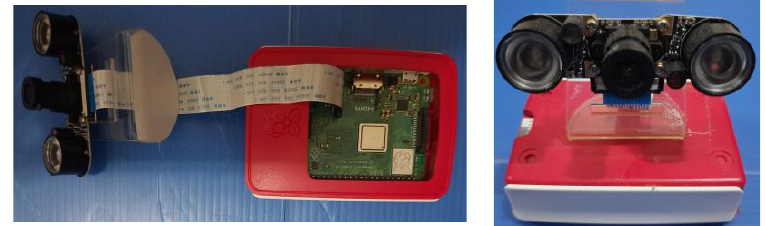
Figure 2. Raspberry Pi NoIR camera module.